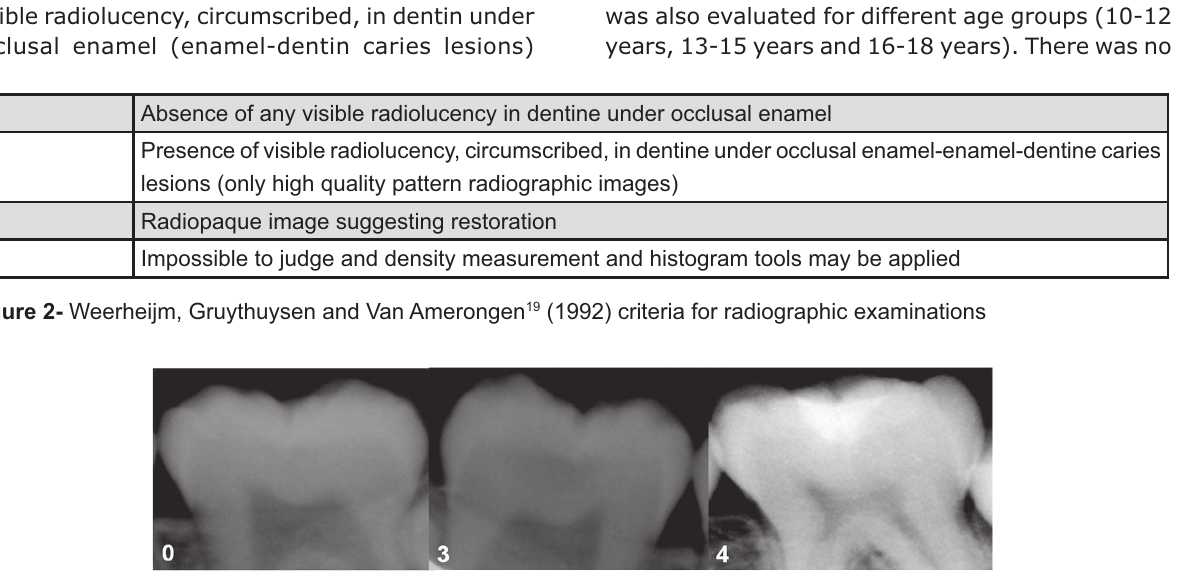
Figure 3- Radiographic aspects of the occlusal surfaces according to Weerheijm, Gruythuysen and Van Amerongen 19 (1992)